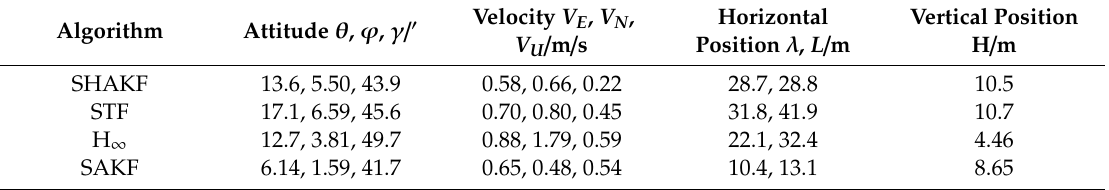
Table 3. The RMS obtained by the output of four algorithms in scene 2 (100 s~150